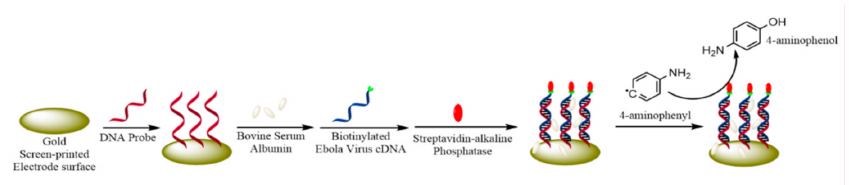
Figure 4. SPE is modified using a DNA probe complementary to Ebola virus (EBV) cDNA. Bi- otinylated EBV cDNA is added, which binds to streptavidin-alkaline phosphatase allowing for the recognition of hybridization through the conversion of 4-aminophenyl to 4-aminophenol. Adapted from Ilkhani et al. [106] with permission from